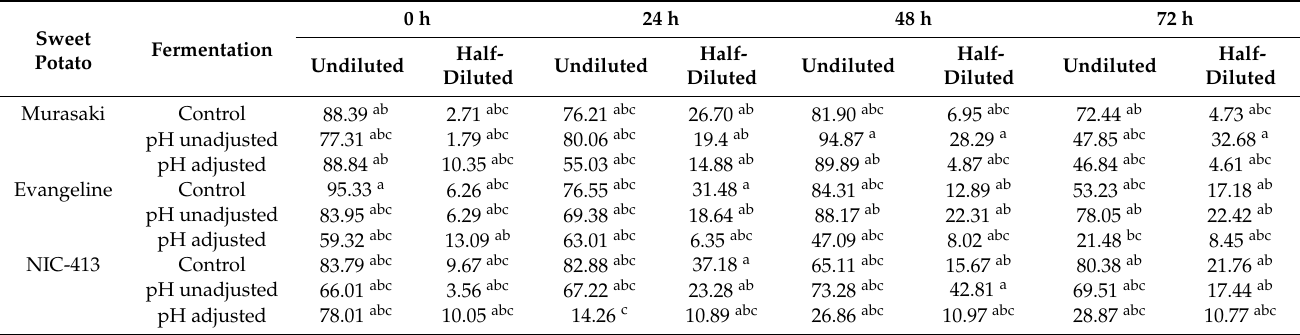
Table 3. α -Amylase enzyme inhibitory (%) activity (undiluted and half diluted) of unfermented and fermented (pH adjusted and unadjusted) sweet potato samples ( n = 12) at 0, 24, 48, and 72 h fermentation time points. Sweet Potato